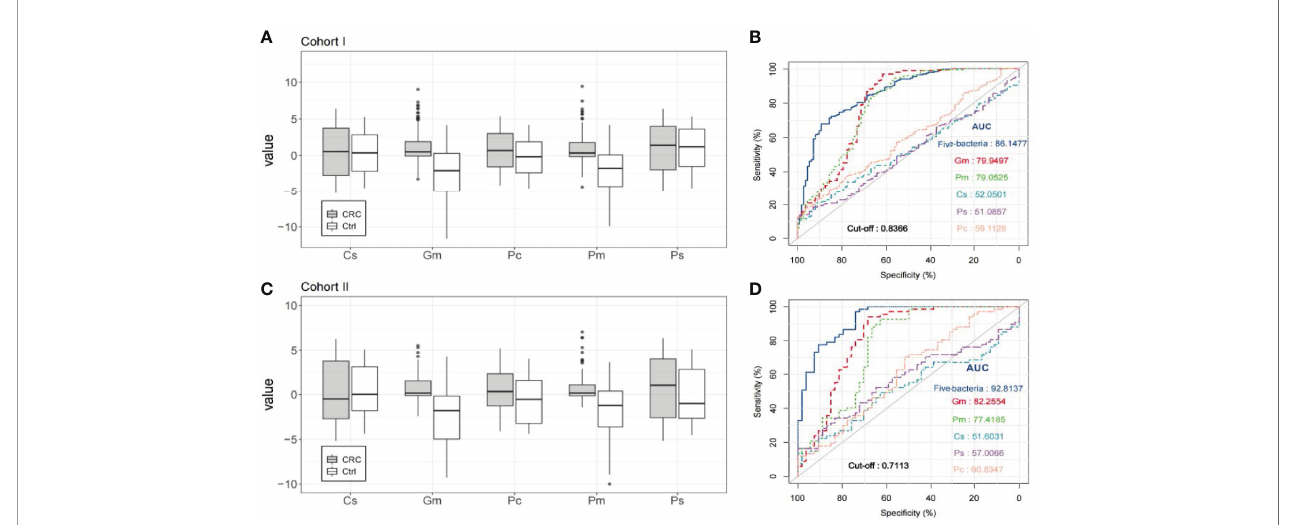
FIGURE 2 | The quantitative detection of fecal bacterial markers in the diagnosis of patients with colorectal cancer (CRC). (A) Relative abundance of fi ve bacteria ( Cs , Gm , Pc , Pm , and Ps ) in the stool of 206 colorectal cancer patients and 112 healthy subjects in cohort I. (B) The receiver operating characteristic (ROC) curve of the markers Cs , Gm , Pc , Pm , and Ps to identify colorectal cancer patients and healthy controls in cohort I. (C) Relative abundance of the fi ve bacteria ( Cs , Gm , Pc , Pm , and Ps ) in the stool of 67 colorectal cancer patients and 54 healthy subjects in cohort II. (D) The ROC curve of the markers Cs , Gm , Pc , Pm , and Ps to identify colorectal cancer patients and healthy controls in cohort II.